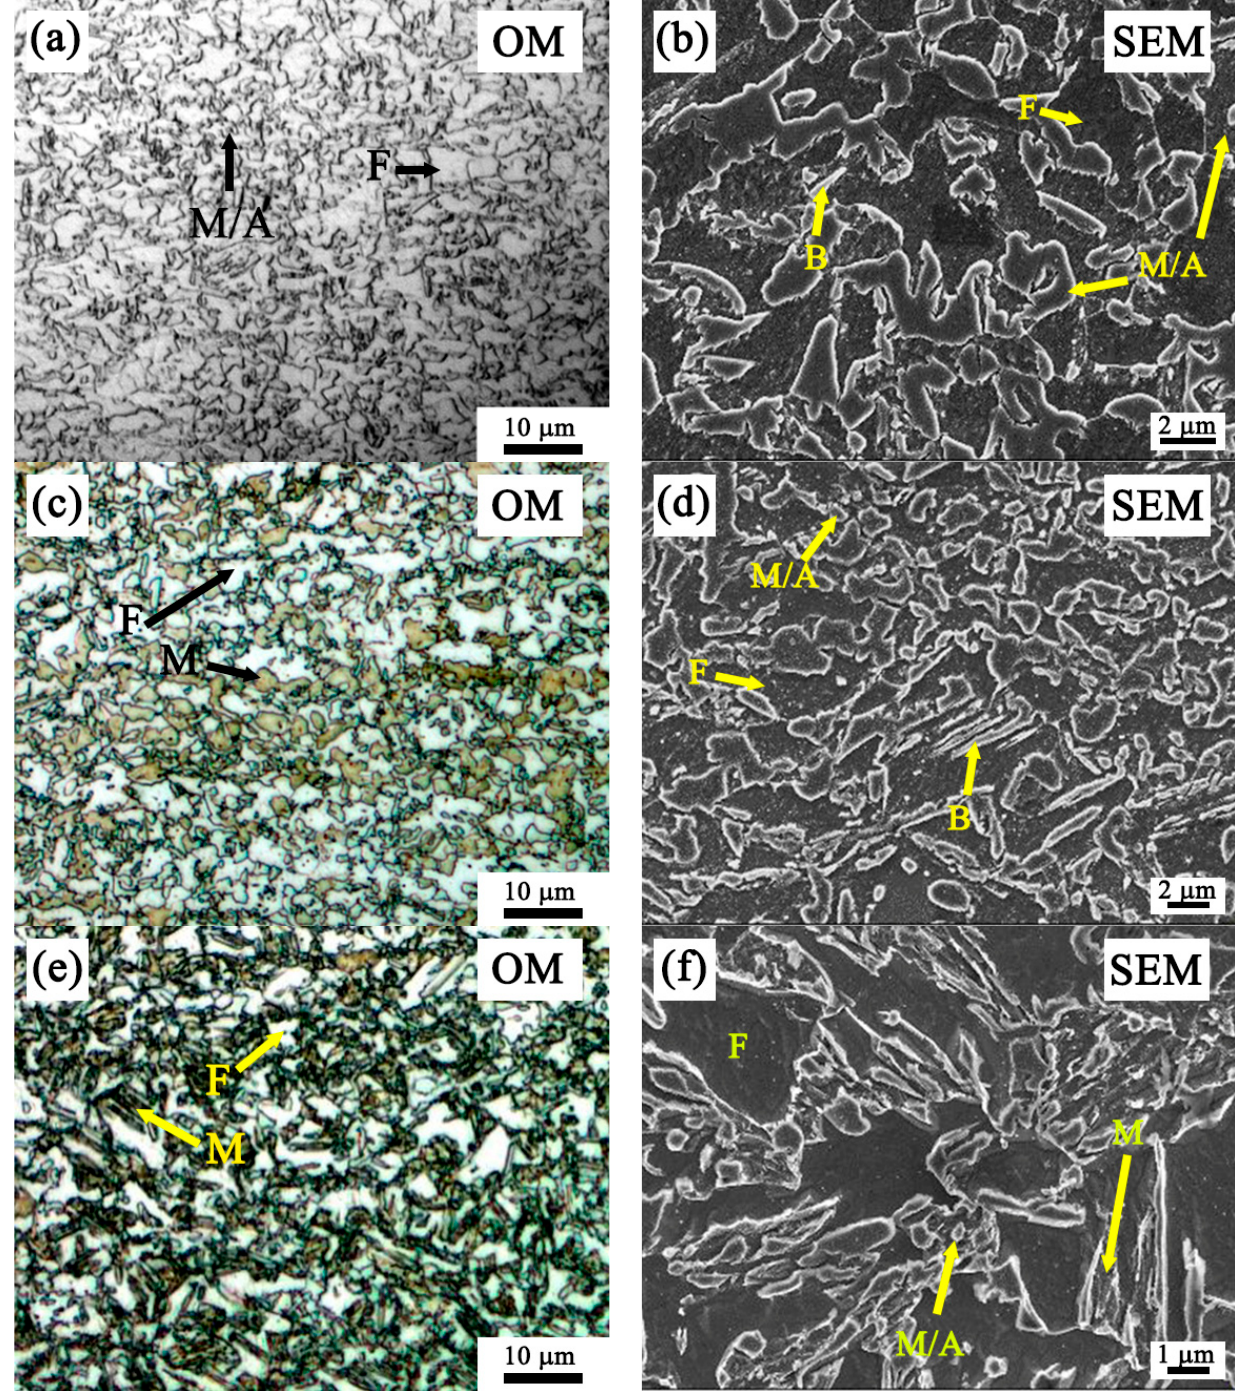
Figure 2. Microstructure morphology of the designed steels: ( a , b ) V-alloyed steel with one-step Q&P process, ( c , d ) Nb-Ti-alloyed steel with one-step Q&P process, and ( e , f ) Ti-alloyed steel with two-step Q&P process. Table 2. The volume fractions of the different phases (%).